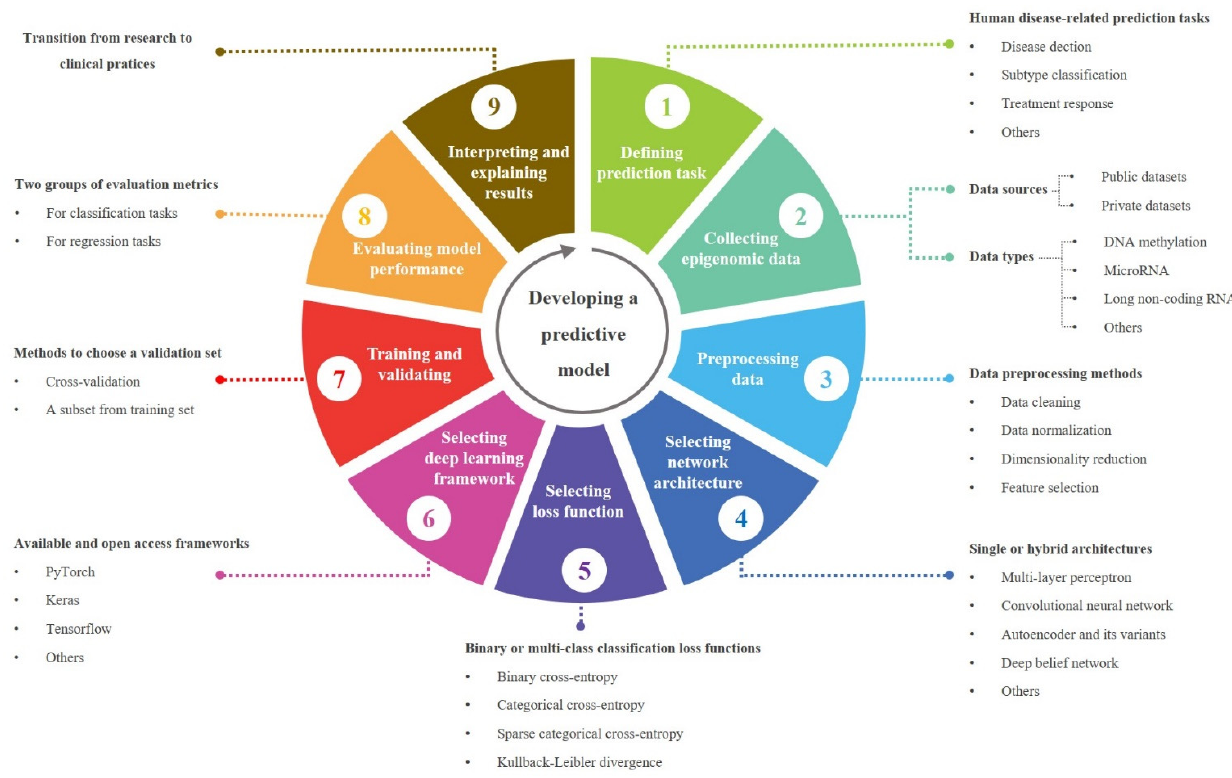
Figure 2. A workflow for developing a predictive model in translational epigenomics.